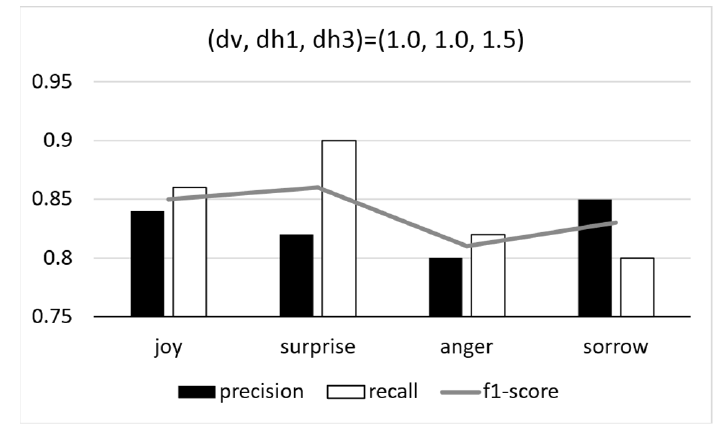
Figure 11. Evaluation results; (dv, dh1, dh3) = (1.0, 1.0, 1.5).